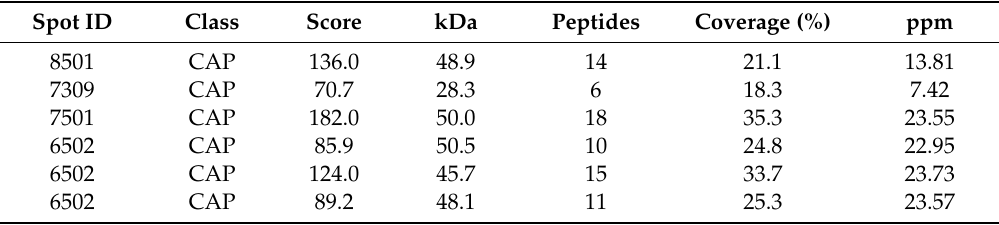
Table 1. Identification of Argiope bruennichi venom proteins by matrix-assisted laser desorption ionization time-of-flight mass spectrometry (MALDI-TOF-MS). Among 152 spots excised from 2D gels, 41 represented proteins that were enriched in the venom glands, and six of these were similar to previously identified venom components, all putative members of the CAP superfamily.